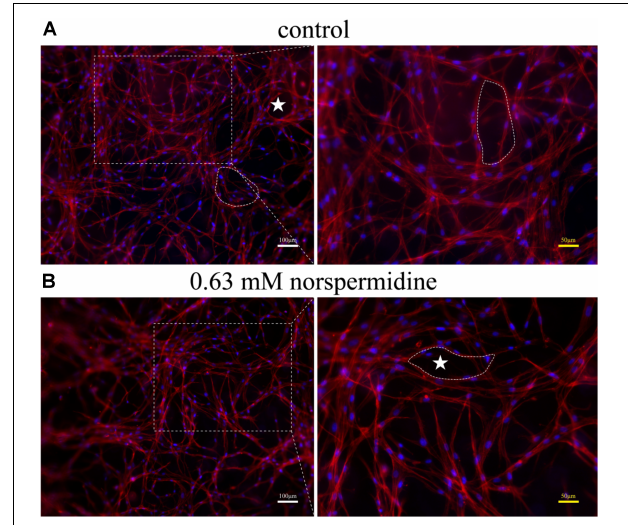
FIGURE 6 | Fluorescence images of capillary-like structure of DPSCs after 7 day angiogenic induction with and without Nspd cultured in GelMA. Differentiated DPSCs were stained with Phalloidin-TRITC (red) to specifically display F-actin, a capillary-like network structure and DAPI (blue) to display cell nuclei. (A) Inducted by growth medium as control; (B) Induced by media with 0.63 mM Nspd. In both groups, capillary-like network was observed (white stars). White bar = 100 µ m, and yellow bar = 50 µ